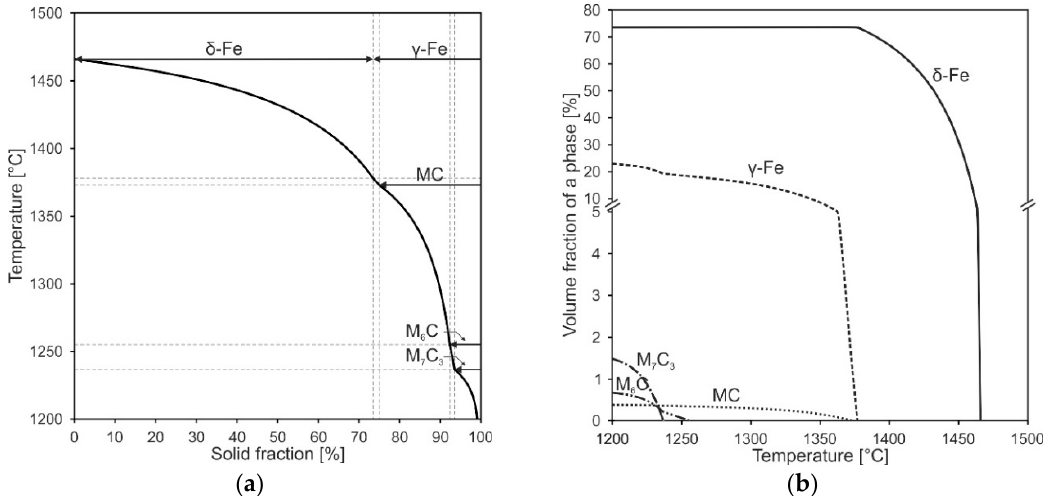
Figure 5. Solidification sequence ( a ) and phase fractions ( b ) of tool steel X36 according to Scheil- Gulliver simulation.